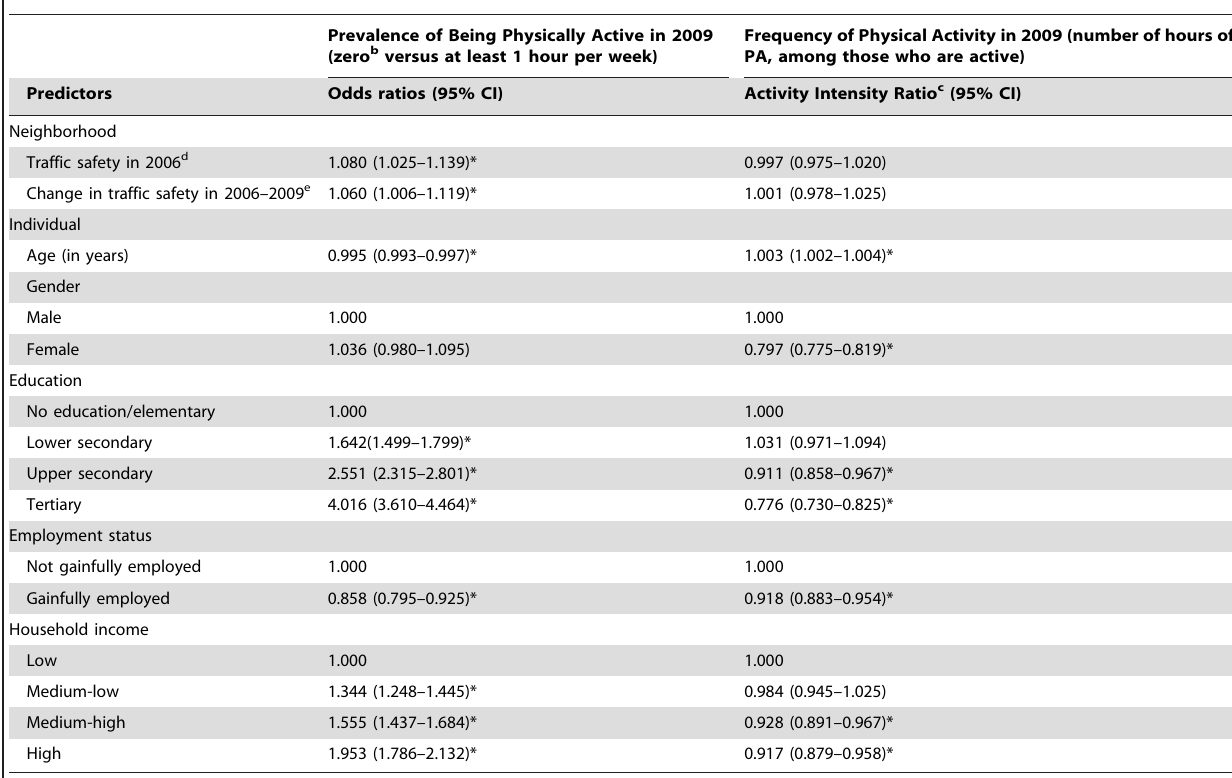
Table 3. Association of physical activity in 2009 with traffic safety in 2006 and change in traffic safety between 2006 and 2009, and sociodemographic variables, for 2009 respondents a .